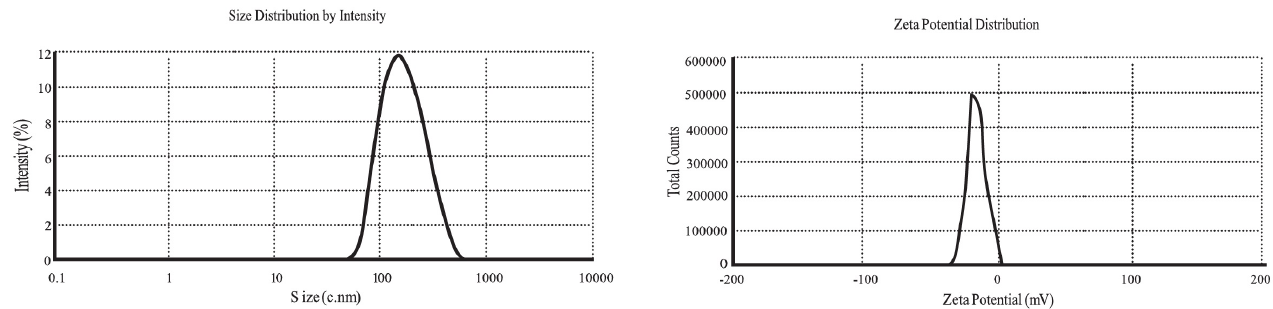
FIGURE 1 - Particle size distribution and Zeta potential measurement of paclitaxel and spirulina nanoparticles measured by